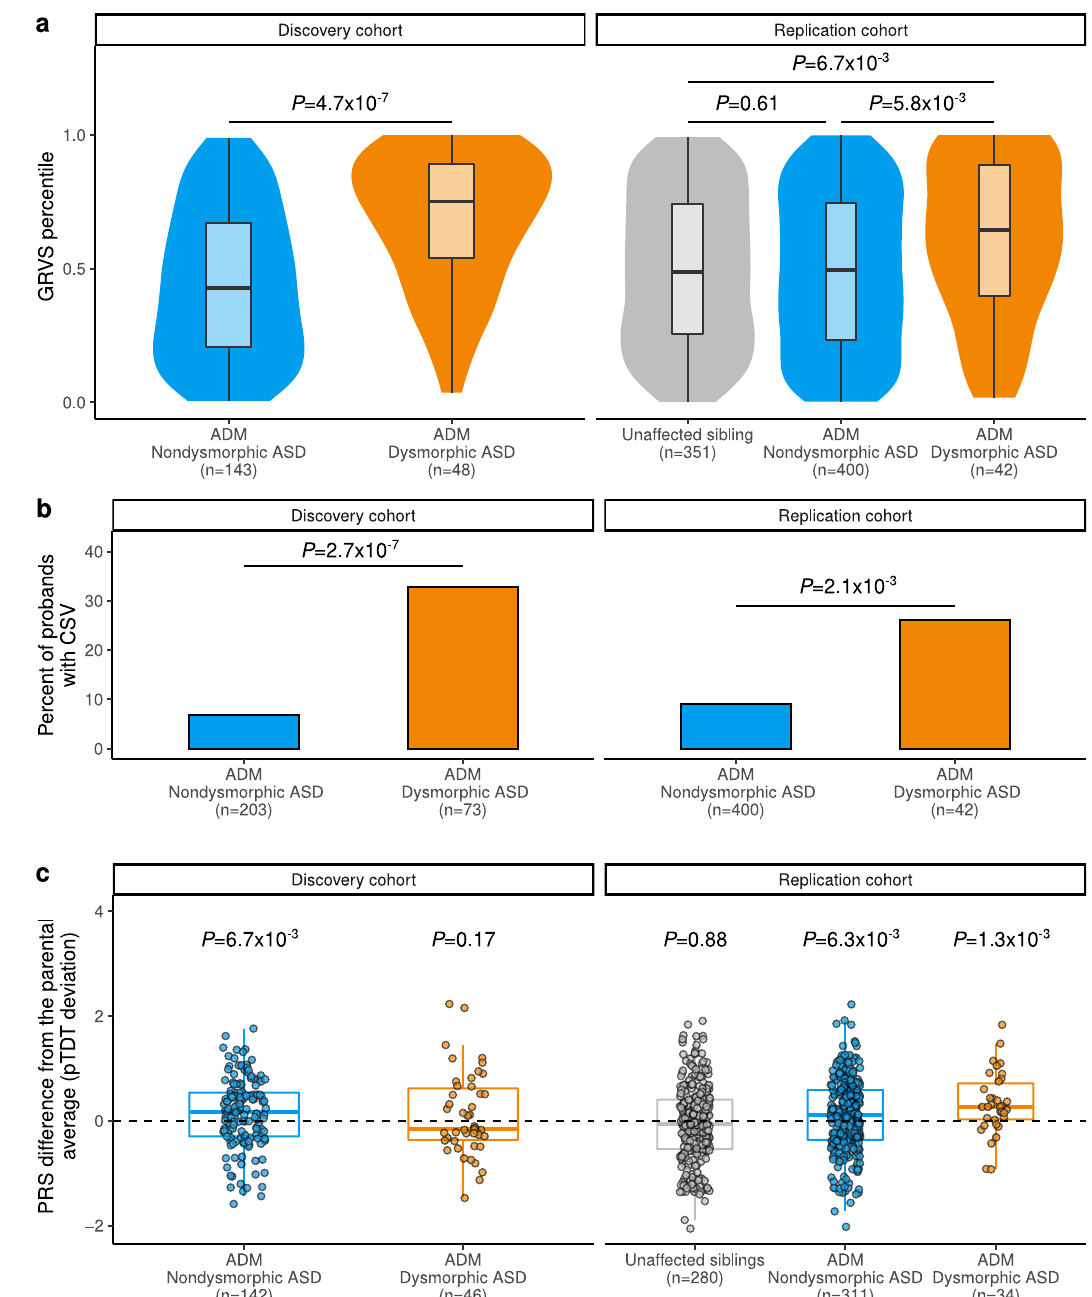
Fig. 6 | Replication of rare and common genetic fi ndings in a subset of Simons Simplex Collection cohort. a GRVSsfor each cohort were ordered and ranked by percentile. Violin plots show the distributions of the probands ’ GRVS percentiles; box plots contained within show the median and quartiles of the percentiles for each subtype, the minima and maxima of box plots indicate 3× the interquartile range-deviated scores from the median. P values denote the probability that the GRVS in ADM-de fi ned dysmorphic ASD is not greater than ADM-de fi ned non- dysmorphic ASD (one-sided, Wilcoxon rank-sum test). b Yield of CSVs between dysmorphic and nondysmorphic subtypes in discovery and replication cohorts. P valuesindicatetheprobabilitythattheyieldofCSVsinnondysmorphicASDisnot lower than that of dysmorphic ASD (one-sided, Welch ’ s t -test). c Inheritance of polygenic risk for ASD in dysmorphic and nondysmorphic ASD subtypes in dis- covery andreplication cohorts. Box plotsdepict the medianand quartilesof pTDT deviation, and the minima and maxima of box plots indicate 3× the interquartile range-deviatedpTDTdeviations from the median. DotsrepresentpTDTdeviations